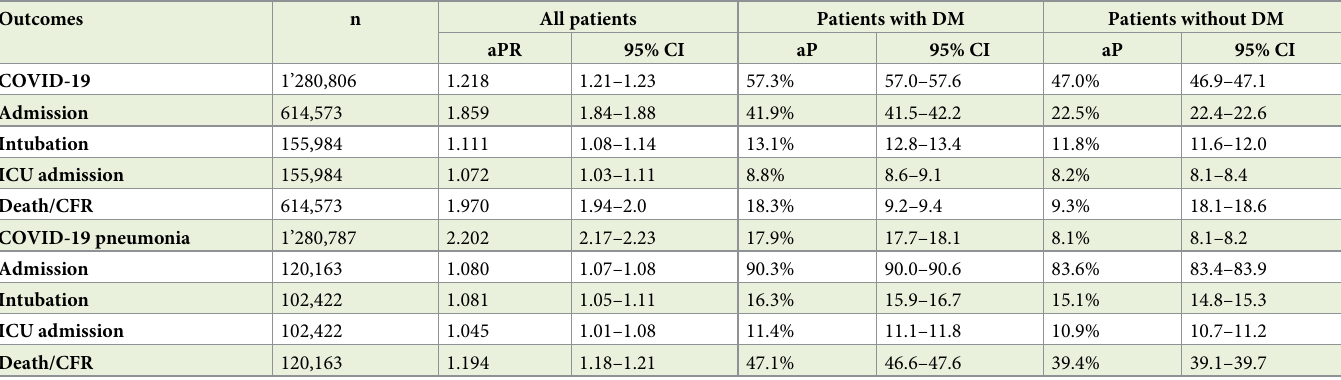
Adjusted prevalence ratios (aPR) and adjusted prevalences (aP) done by age, sex and altitude for patients with and without DM shown along 95% CIs. All results are statistically significant at p <